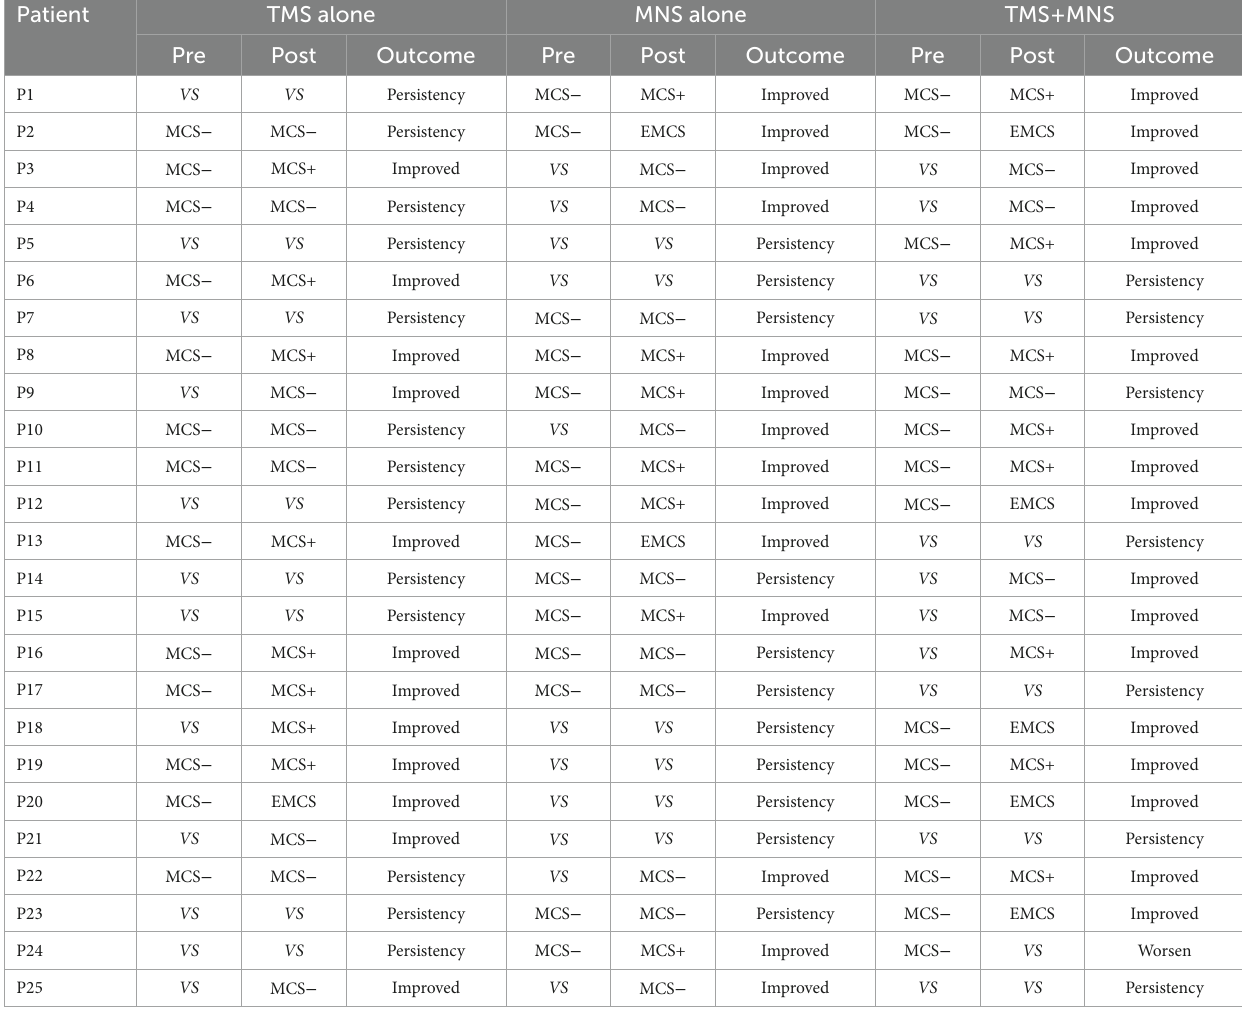
TABLE 2 Clinical diagnosis pre- and post-treatment and the improvements in consciousness level in the three groups. Patient